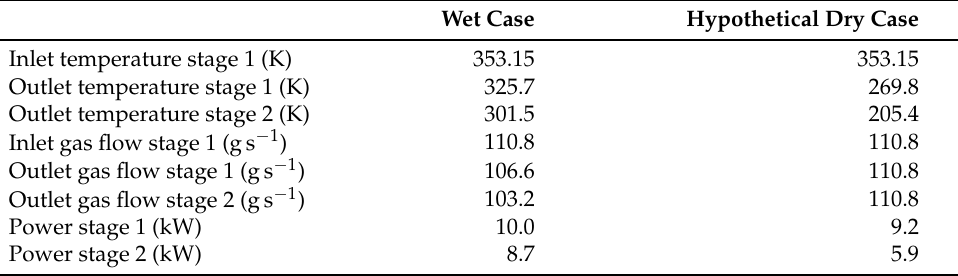
Table 1. Comparison of turbine performance data for a dry and wet flow. Wet Case Hypothetical Dry